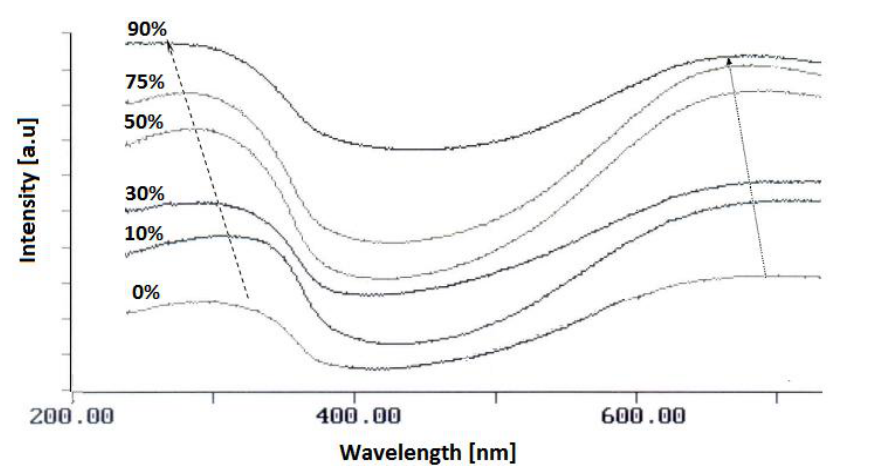
Figure 4. UV-Vis spectra of TiO